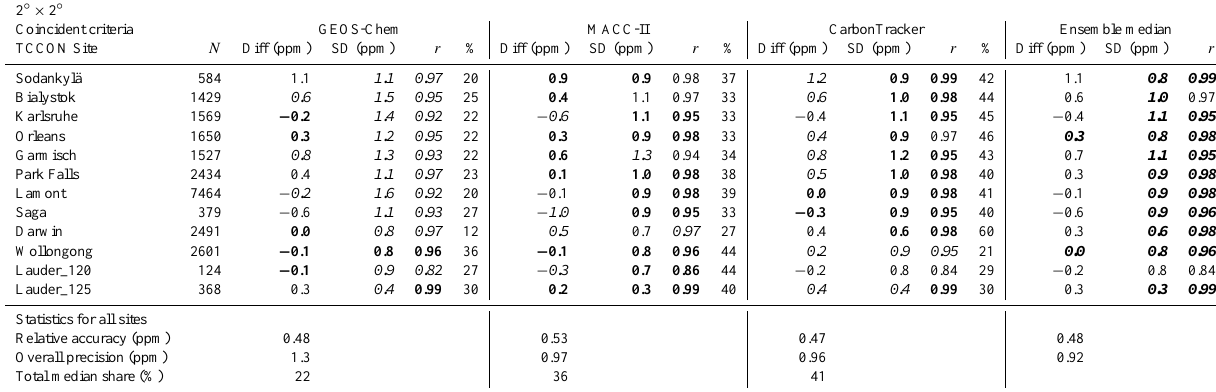
Table A1. Table showing the comparison statistics between each XCO 2 model (sampled as per the GOSAT measurements) within ± 2 ◦ of each TCCON site against the TCCON validation data. The difference (model − TCCON), the standard deviation of the difference, and the correlation coefficient are all provided as is the total number of measurements for each site, N , and the percentage “share” of the median for each model, %. For each of the three models, GEOS-Chem, MACC-II, and CarbonTracker, the best (bold) and worst (italic) value for each metric is highlighted. For the ensemble median data, all values which are better than the best individual model value are highlighted in bold-italic. The lower panel provides overall statistics across all sites. These include the relative accuracy (the standard deviation of the individual site biases), the overall precision (the standard deviation of the GOSAT − TCCON differences), and the overall share that each model contributes to the median ensemble.